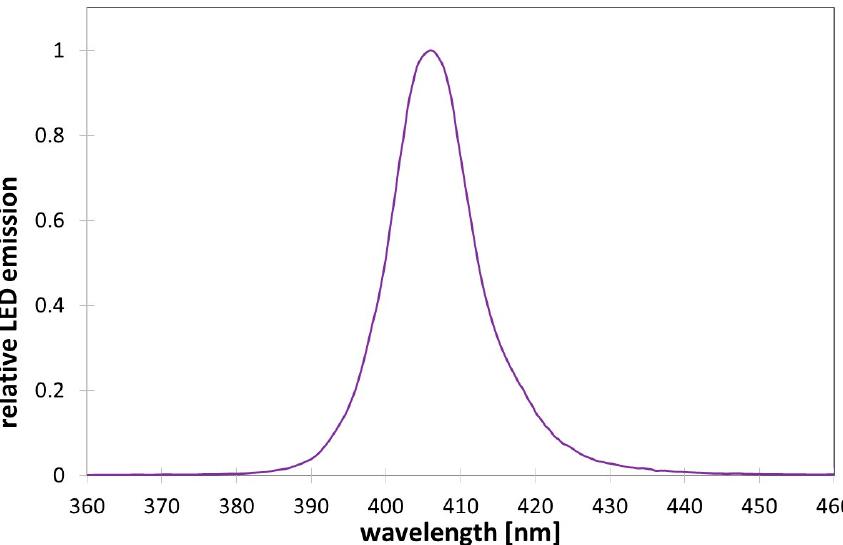
Figure 2. Relative emission spectrum of the employed Nichia LED at a total current of 2.5 A or 156 mA per LED with a measured peak wavelength of 406 nm.